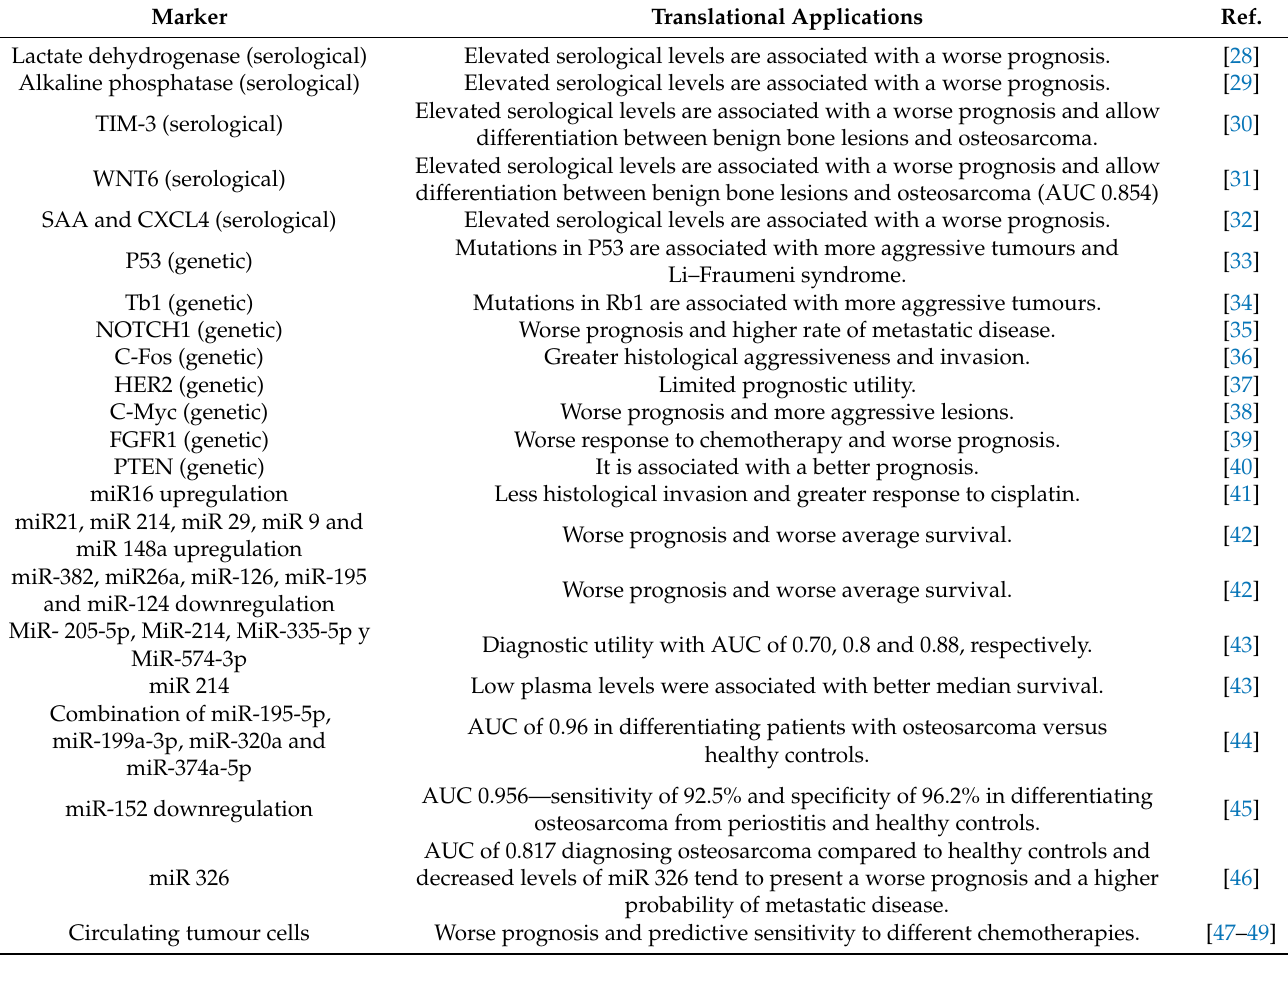
Table 1. Main biomarkers and translational applications explored in osteosarcoma.